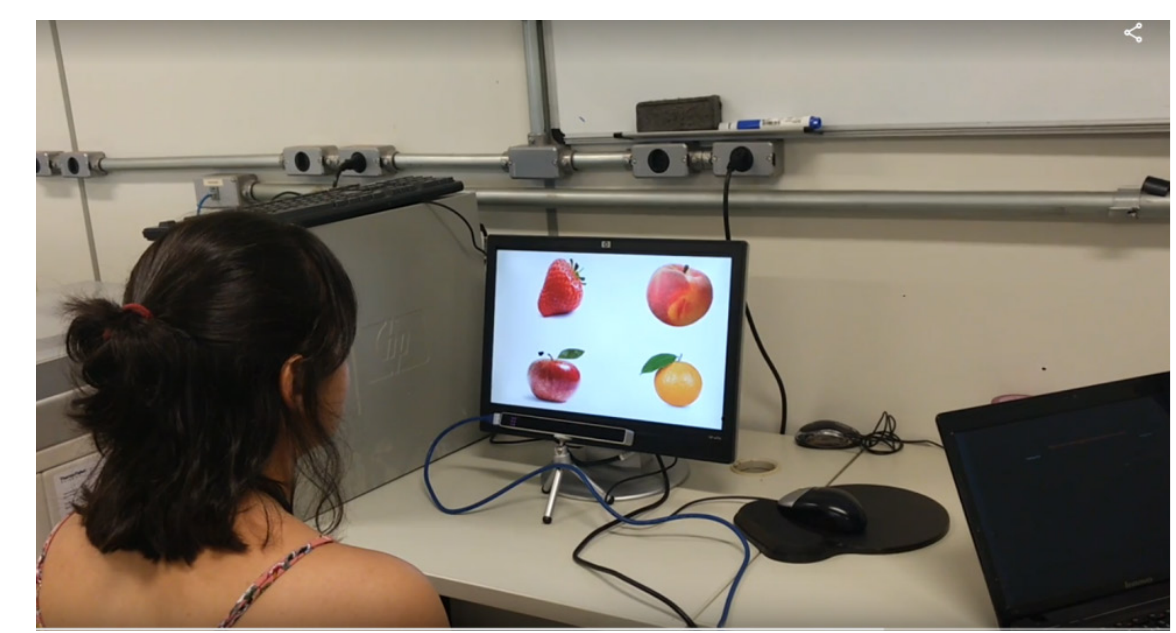
FIGURE 2 – Participant viewing the